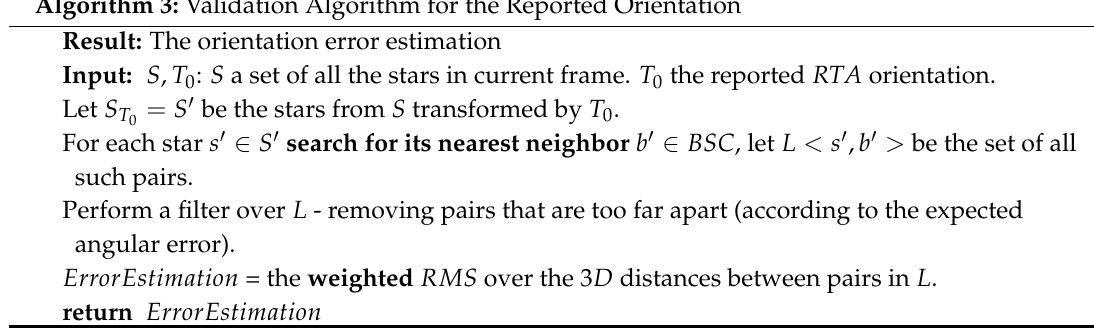
Algorithm 3: Validation Algorithm for the Reported Orientation Result: The orientation error